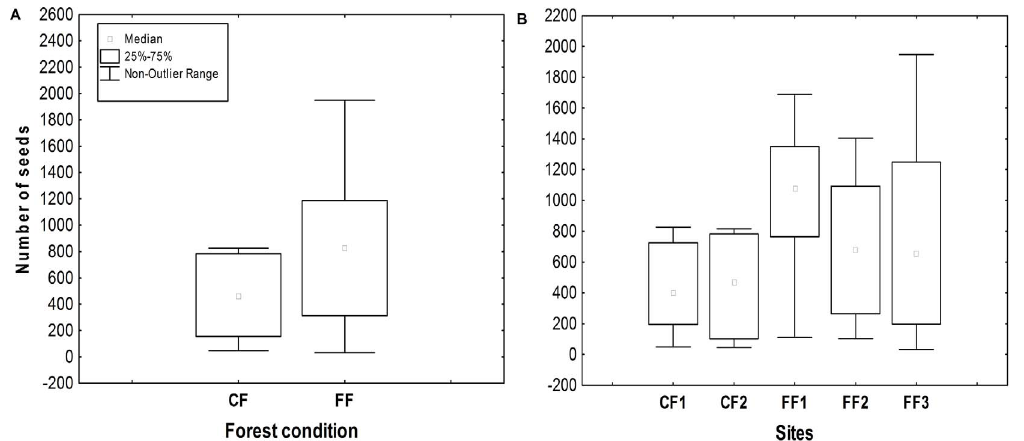
Figure 2. Abundance of seeds deposited by spider monkeys in latrines located in continuous and fragmented forests in the Lacandona region, Mexico. We show differences between forest conditions considering medians per site (a), and among sites based on medians per latrine (b). FF = forest fragments ordered from the largest to the smallest; CF = continuous forest sites.